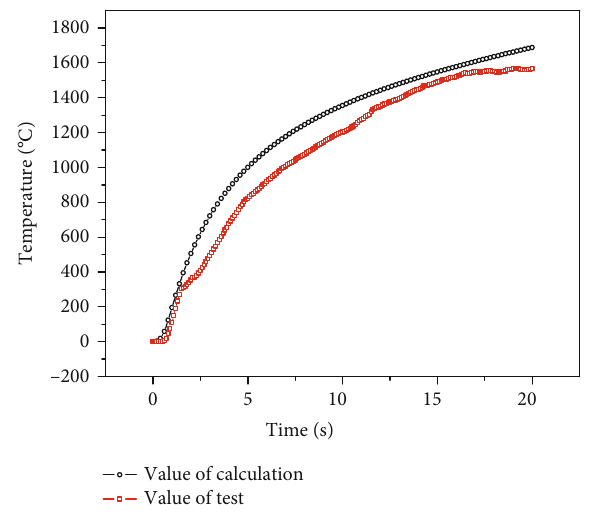
Figure 10: The comparison between calculated results and test results of the temperature fi eld.